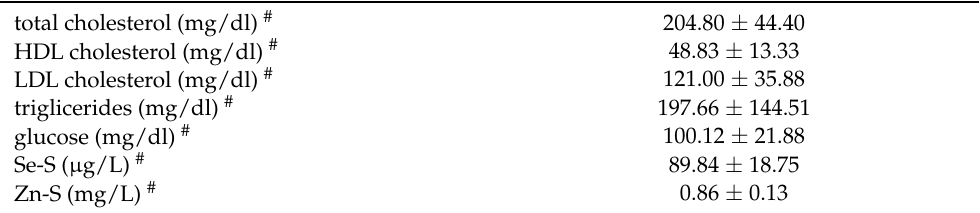
Table 2. Laboratory tests in the study